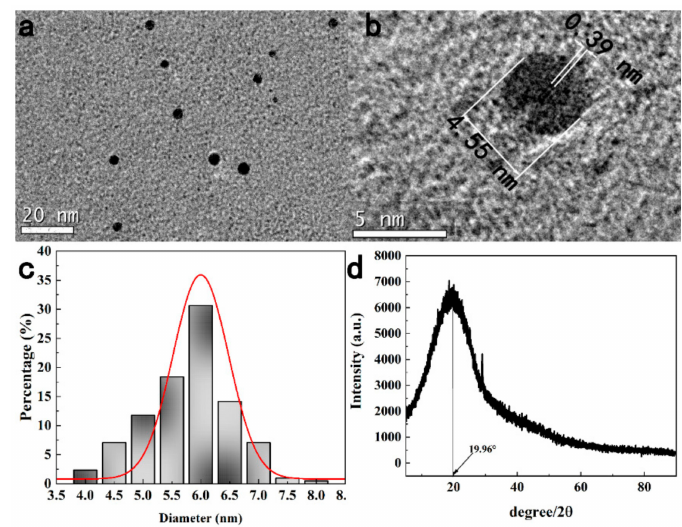
Figure 2. ( a ) TEM image of N-CDs, ratio scale is 20 nm. ( b ) HRTEM image of N-CDs, ratio scale is 5 nm. ( c ) Diameter distribution of N-CDs. ( d ) XRD pattern of N-CDs.